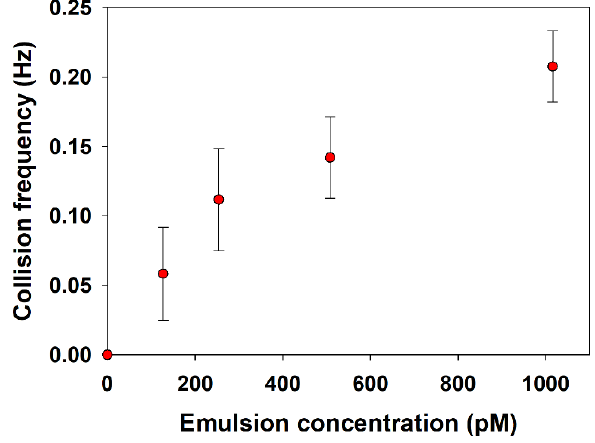
Figure 4. Plot of the collision frequency (Hz) as a function of the W/O emulsion concentration (pM). The error bars indicate the 3 times of the standard deviation of 6 independent measurements. All experiments were conducted on a Pt-UME biased at 1.0 V (vs. Ag/Ag + ).